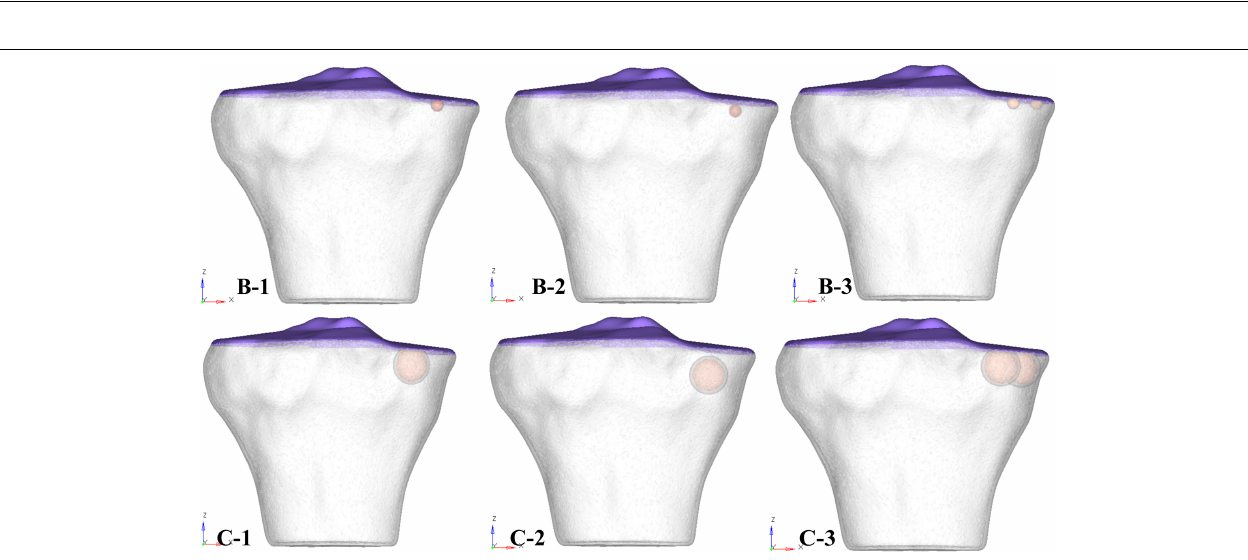
FIGURE 1 | 3D knee models. (A) Non-cystic 3D knee model showing different structures, (B) model of SBC knee model, and (C) finite element model showing loading and boundary conditions. SBC, subchondral bone cyst.